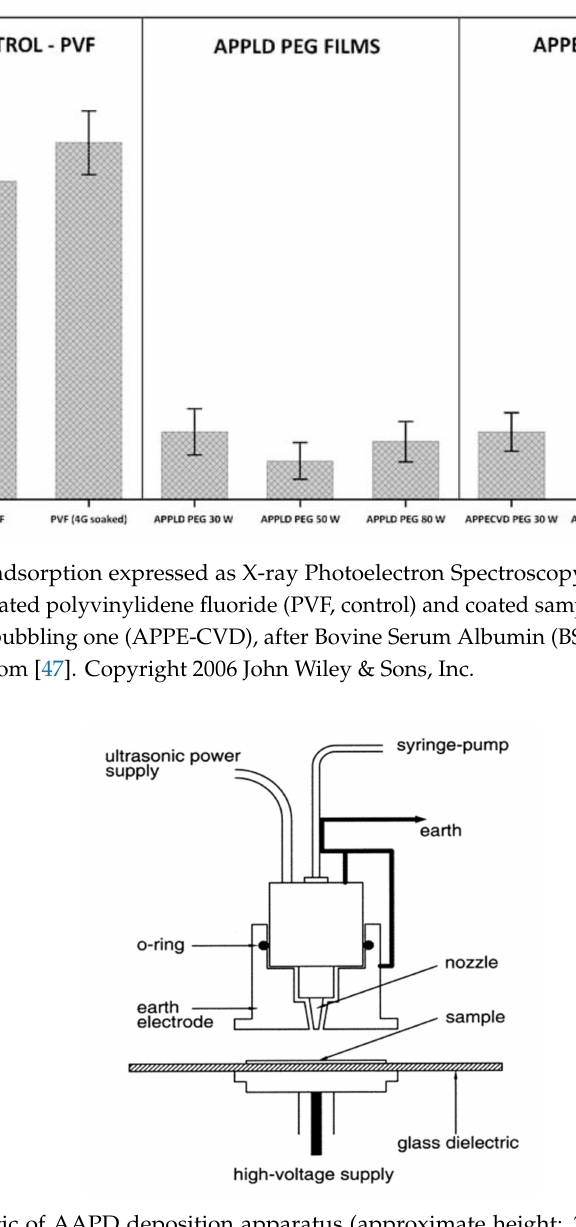
Figure 7. Schematic of AAPD deposition apparatus (approximate height: 30 cm). Reprinted with permission from [33]. Copyright 2003 American Chemical